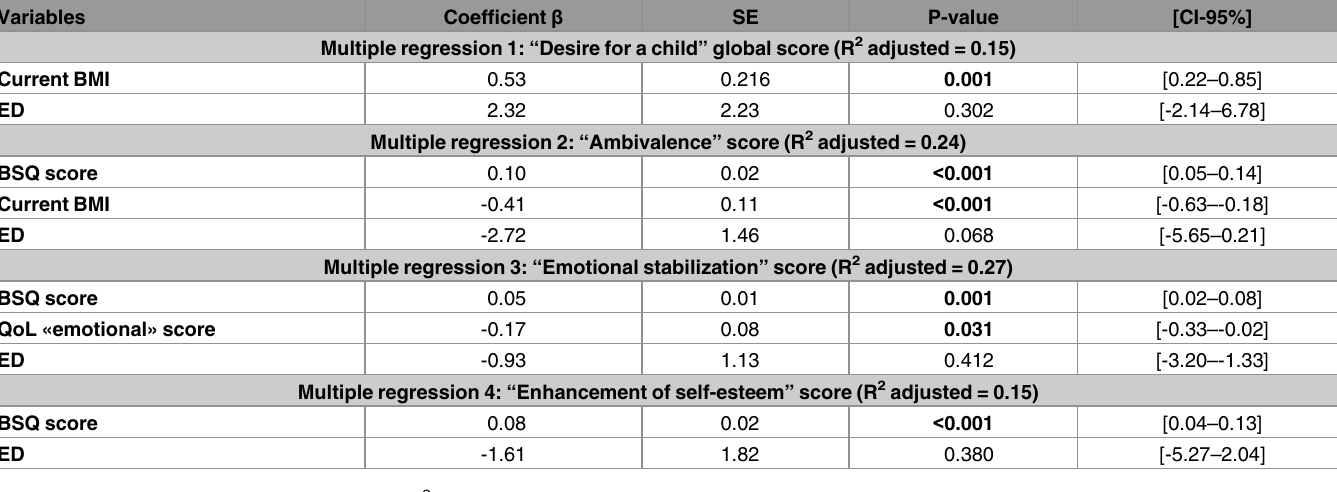
Table 3. Multiple regressions based on the desire for a child assessedwith the FKW questionnaire (global score and three dimensional scores). Variables Coefficient β SE P-value [CI-95%] Multiple regression 1: “Desire for a child” global score (R 2 adjusted = 0.15)